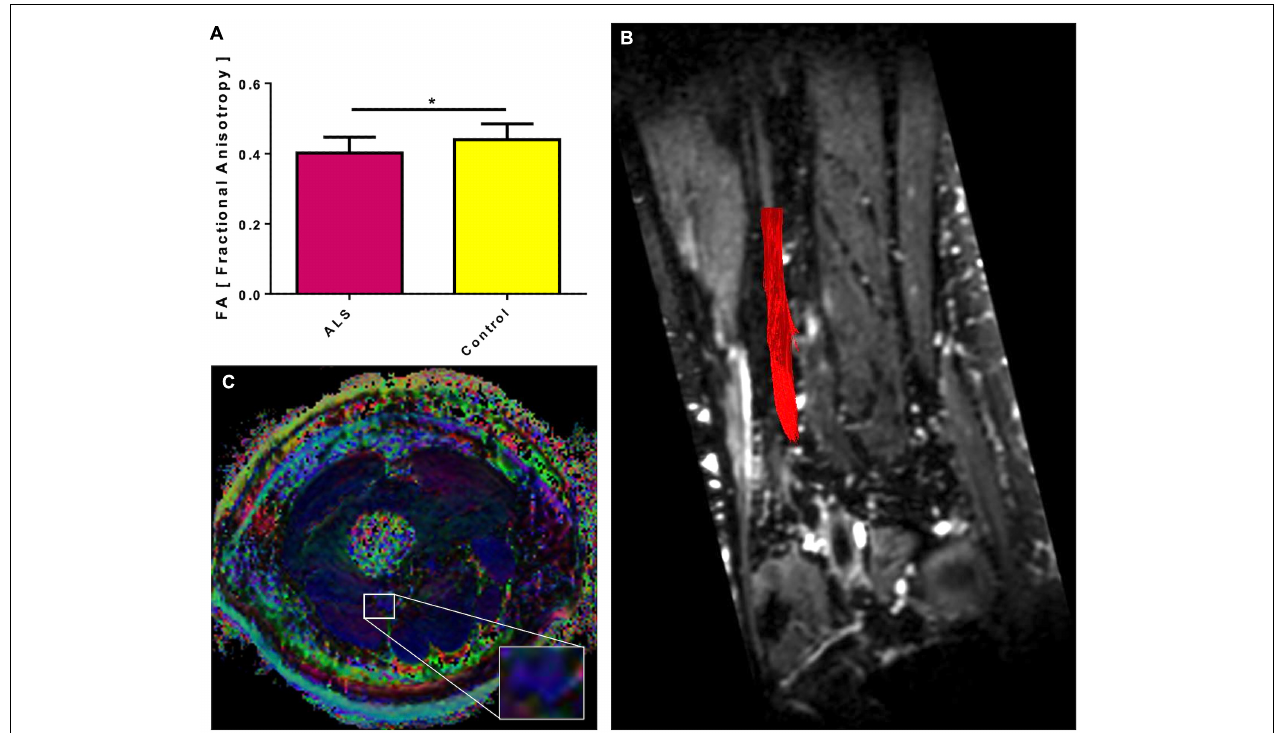
FIGURE 1 | Fractional anisotropy (FA) of the sciatic nerve in ALS patients compared to controls. The sciatic nerves of ALS patients show a lower mean FA than healthy controls (A) . Significant differences are indicated by asterisks (* p < 0.05, ** p < 0.01, *** p < 0.001). In (B) , for illustrative purposes, a deterministic fiber tracking of the sciatic nerve was projected in red color on a coronary reconstruction of the 3D T2 TSE sequence. In (C) , an exemplary color-coded FA map of an ALS patient is shown with the sciatic nerve magnified. The blue color of the nerve corresponds to a head-to-foot directional